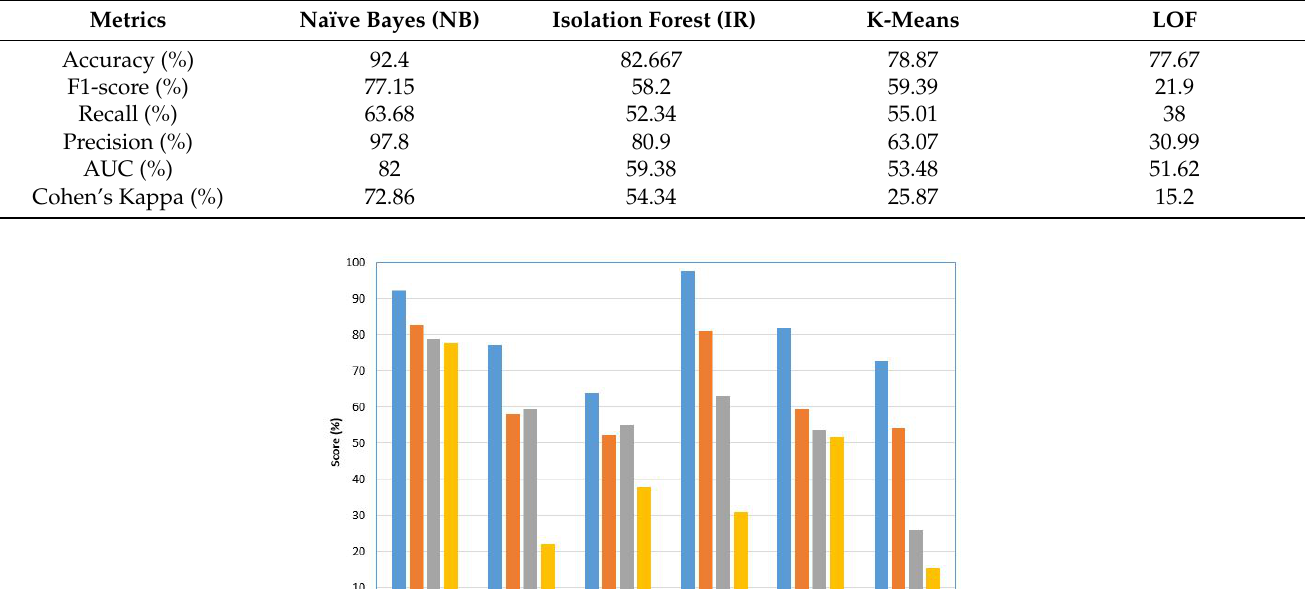
Table 6. Performance analysis of the BR/EDR IDS using unsupervised—ML algorithms.